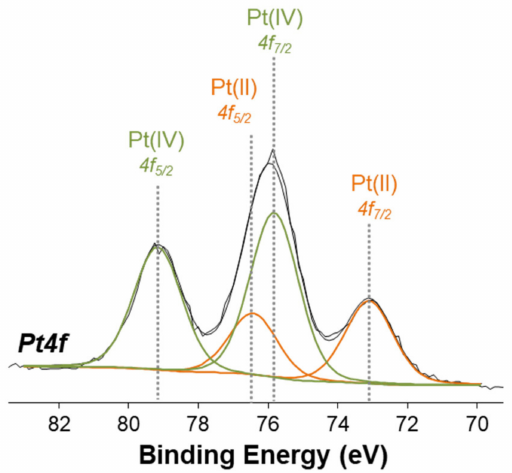
Figure 7. Pt4f XPS spectrum of complex 2